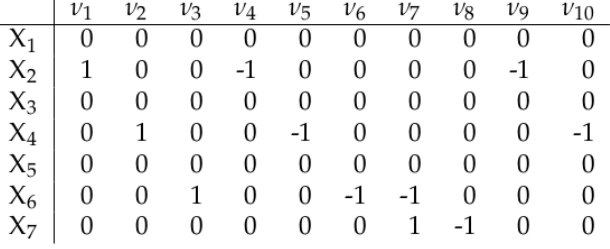
Figure 2. Stoichiometric matrix for the chemical reactions